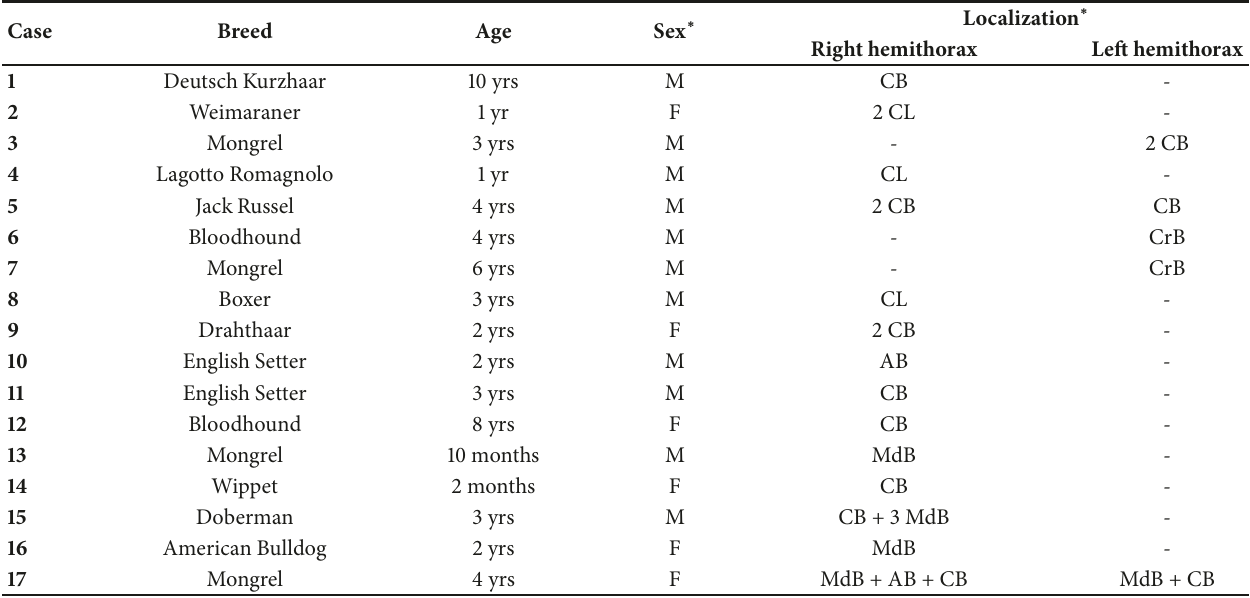
Table 2: Breed, age, and sex of dogs included in the present study and localization of the grass awns in the lower respiratory tract ( ∗ F = female; M = male; B = lobar bronchus; C = caudal; Cr = cranial; Md = middle; A = accessory; L = lung; CL = caudal lobe).